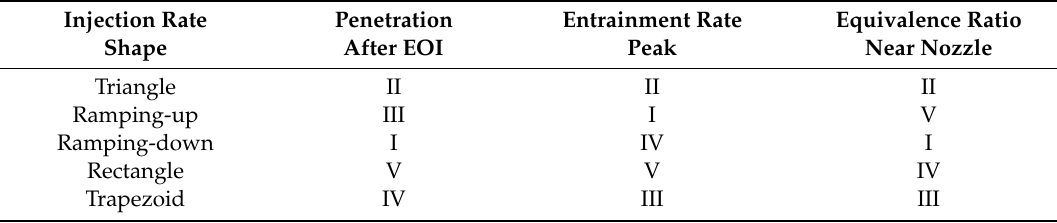
Table 4. Comparison of spray characteristics under varying injection rate